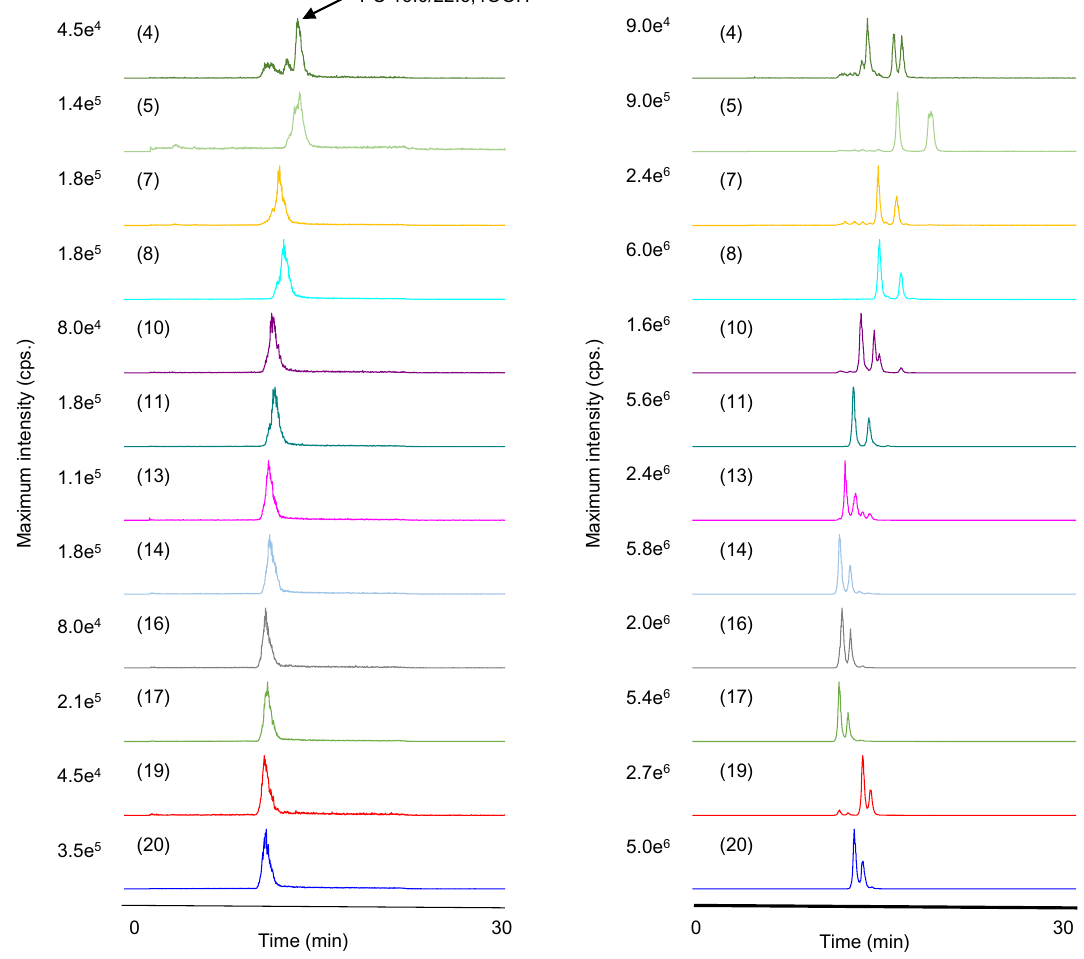
Figure 4. LC–MS/MS chromatograms of the model samples of PC 16:0/22:6 (left) and TG 18:1_18:1_22:6 (right). Values given in parentheses indicate the hydroperoxyl group position. The chromatogram of